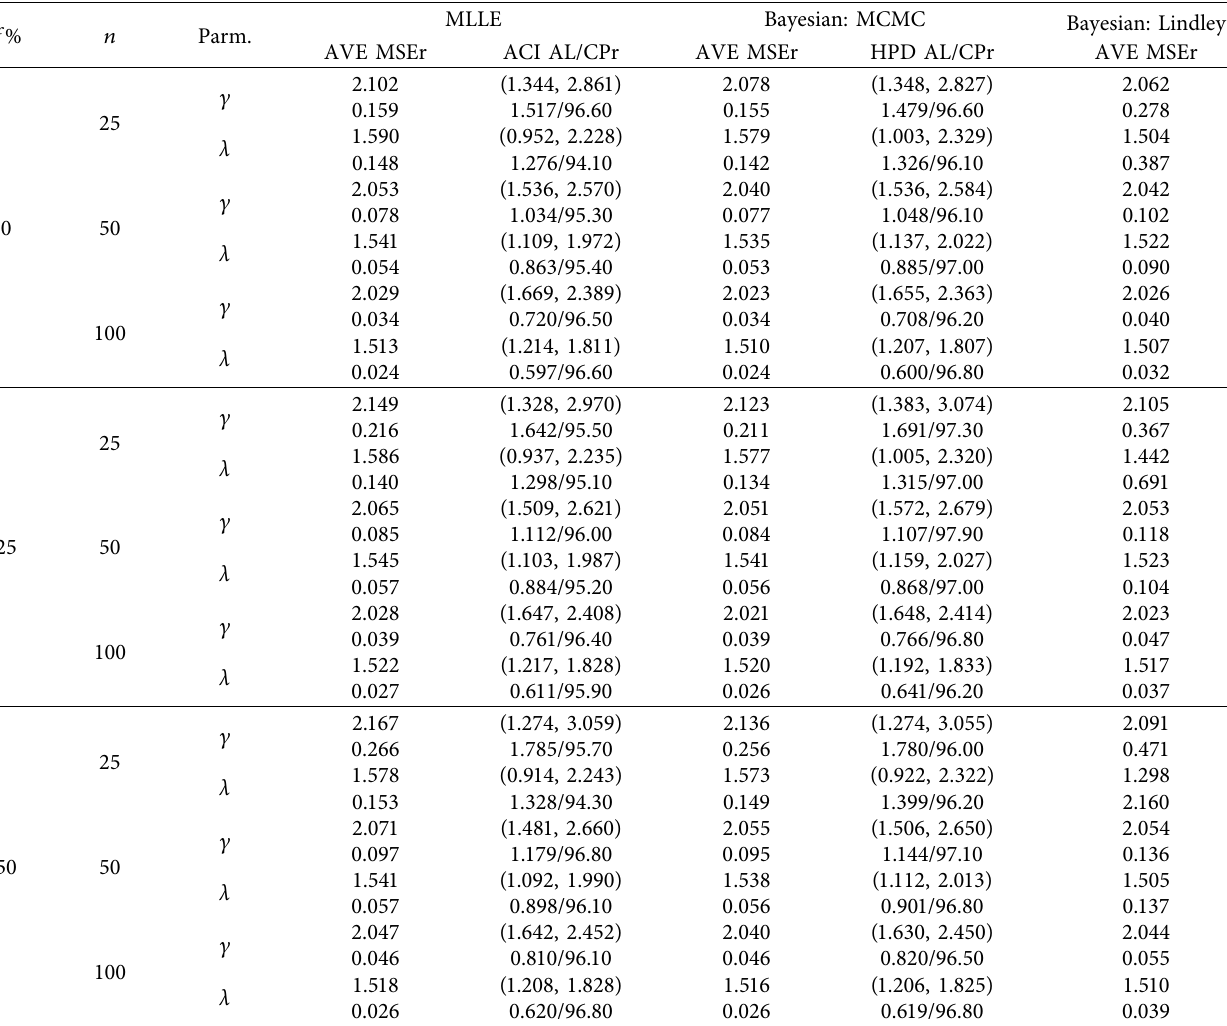
Table 1: Numerical results of AVEs, ACIs, MSErs, ALs, and CPrs (in %) for c � 2 and λ � 1 . 5 under number of stages m � 3. MLLE f % n Parm.